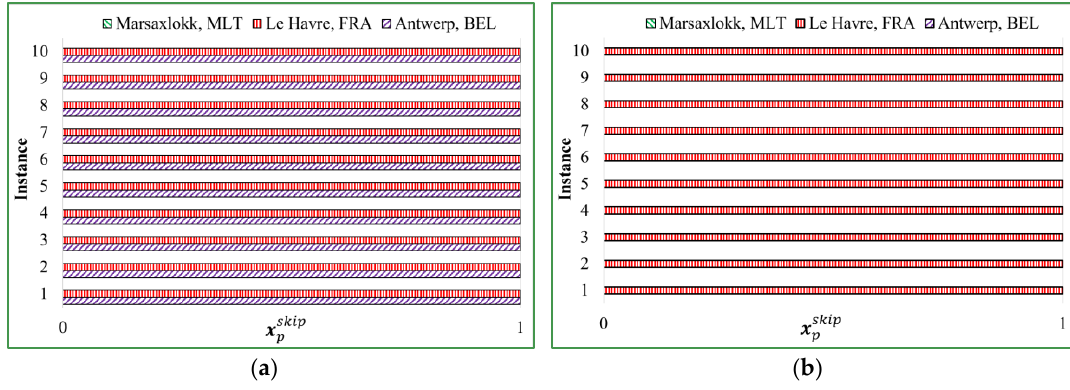
Figure A3. The port skipping decisions for disruption case 3: ( a ) 𝜇 = [1.0] ÷ [7.0] ; and ( b ) 𝜇 = [8.0] ÷ [10.0] .